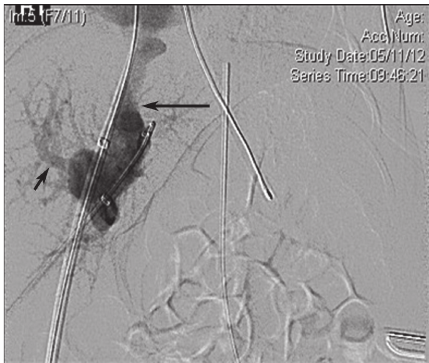
Figure 3: Percutaneous venogram demonstrating opacification of the right portal vasculature (short arrow) and the left hepatic vein (long arrow) from a manual injection following percutaneous access at the junctional fistulous communication point between the left portal vein and left hepatic